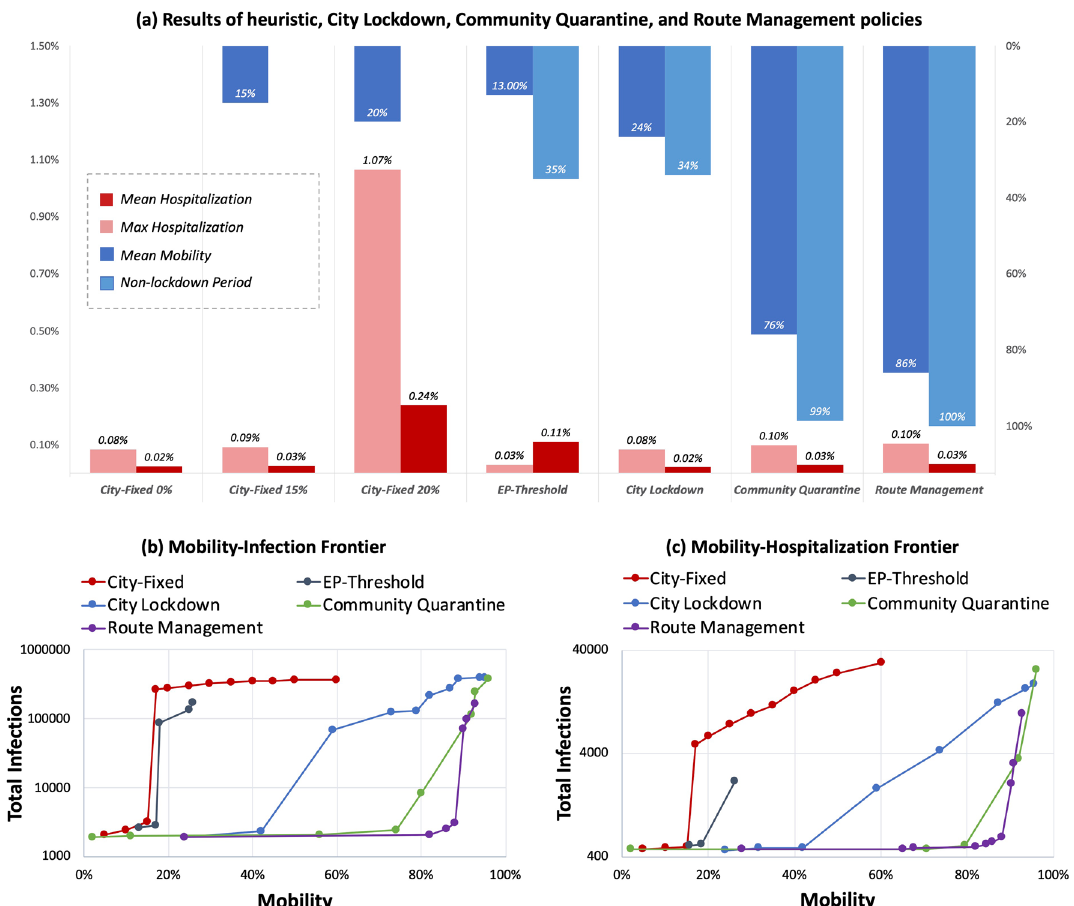
Figure 5. The cost-benefit relationship between mobility retention and pandemic